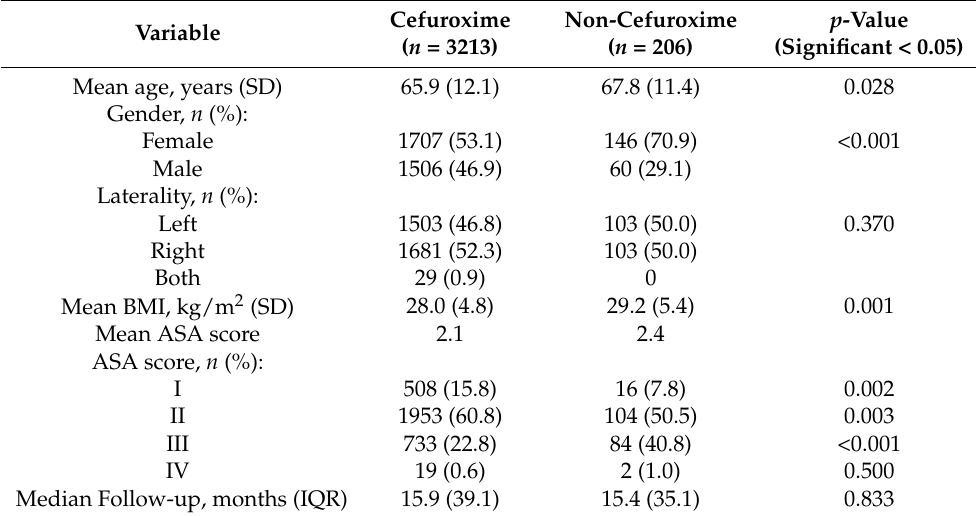
Table 1. Demographics in total hip arthroplasty group according to prophylactic antibiotic.